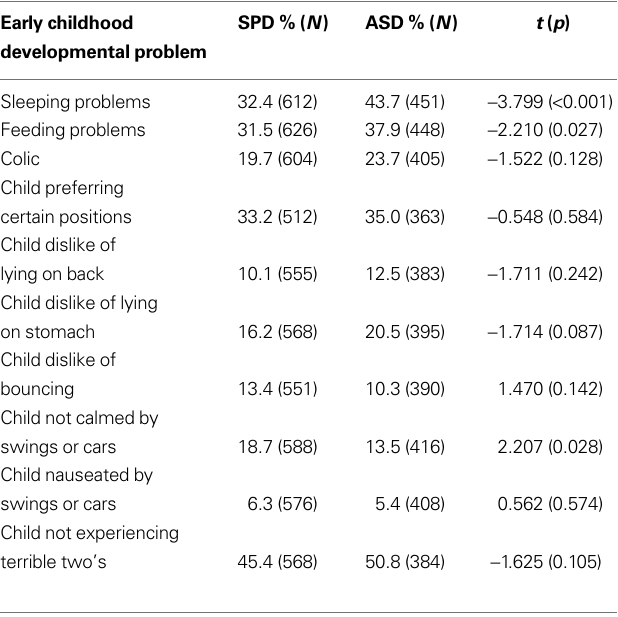
Table 7 | Percentage, valid N , and T -tests of infancy and early childhood developmental